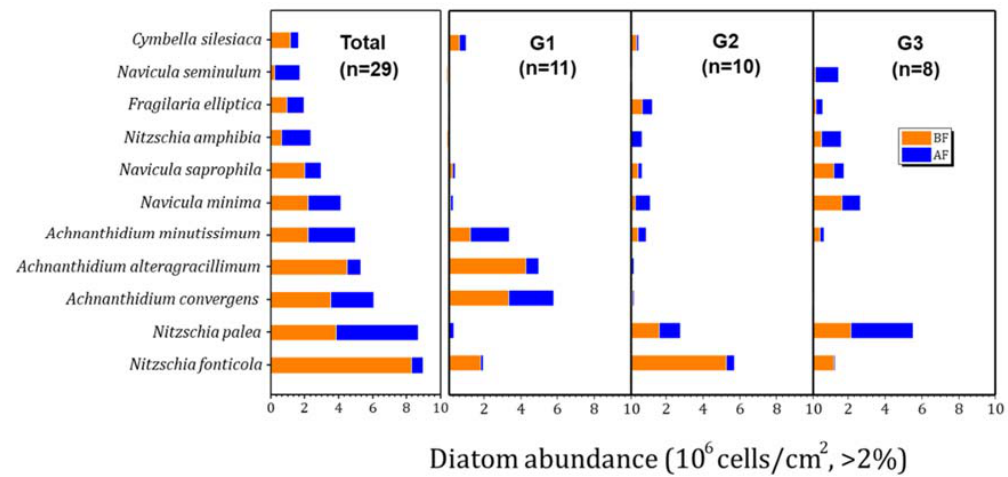
Figure 4. Total abundances of most abundant epilithic diatom species in each group (G1–3) in the Hantangang River before (BF) and after monsoon (AF) from 2012 to 2015. BF: before monsoon, AF: after monsoon. Table 3. The correlation coefficients between the dominant diatom species (DS) and water quality parameters before and after the monsoon in the Hantangang River, from 2012 to 2015.